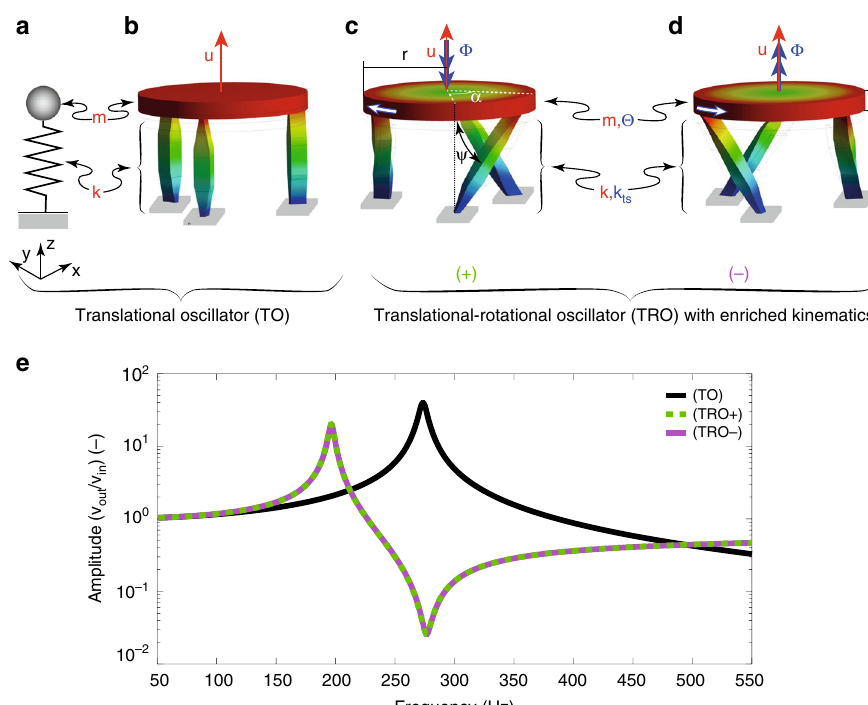
Fig. 2 Dynamic behavior of ordinary and enriched kinematics oscillators. a , b Schematics and three-dimensional model of TO with mass m and axial stiffness k . The oscillator can translate in the z -direction but cannot rotate, in agreement with the idea that atoms are point masses. c , d TROs with enriched kinematics transcending the Haüy-Boscovich model, thanks to their fi nite extension. Non-centrosymmetric links couple the linear motion ( u ) of the disks along the translational direction ( z ) to their rotation ( Φ ) about the same axis. The colors in Fig. 2b-d refers to the magnitude of the displacement at the fi rst resonance of the structures, with blue being the smallest and red the largest total displacement, respectively. e Amplitudes of the vertical displacement as a function of frequency resulting from a numerical forced frequency response analysis for the three structures reported in Fig. 2b – d. Refer to Supplementary Note 2 for a TRO frequency response up to higher frequencies. Animations of the modes are available online in Supplementary Movies 1 – 3